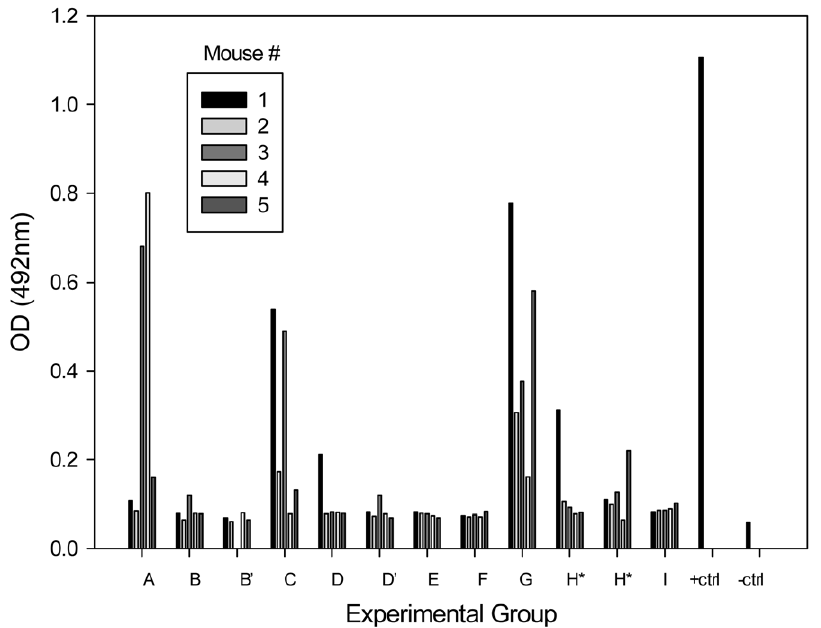
Figure 5. C.albicansc olonization of mice may result in appearance of serum antibodies specific for a mannan extract of the fungus. By day 71, serum antibody was especially obvious in mice that were treated with antimicrobial agents and received C. albicans in their drinking water (i.e., groups A, C and G;see Table 3). Only one mouse from each of two groups that became colonized later as a result of horizontal transmission had evidence of serum antibody (groups B and D). Note that the sera from groups H and H’ were not properly marked for identification of H or H’ and were, thus, both designated as H* and H*. The positive control ( + ctrl) for the ELISA was monoclonal antibody B6.1, which is specific for a mannan component in the C. albicans cell wall. The negative control (-ctrl) contained all of the ELISA reagents except for primary antibody, which was omitted.